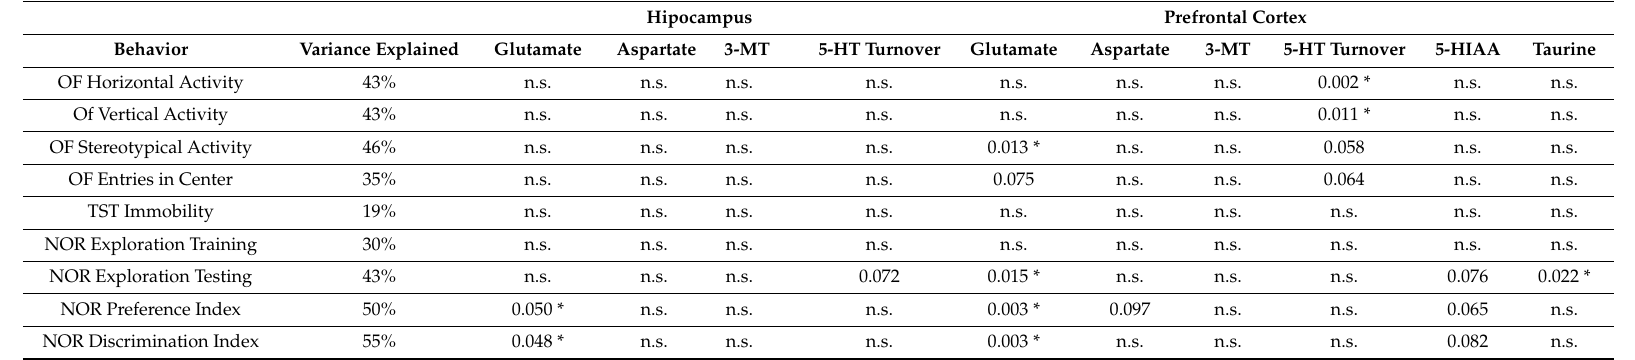
Table A3. Multivariate Linear